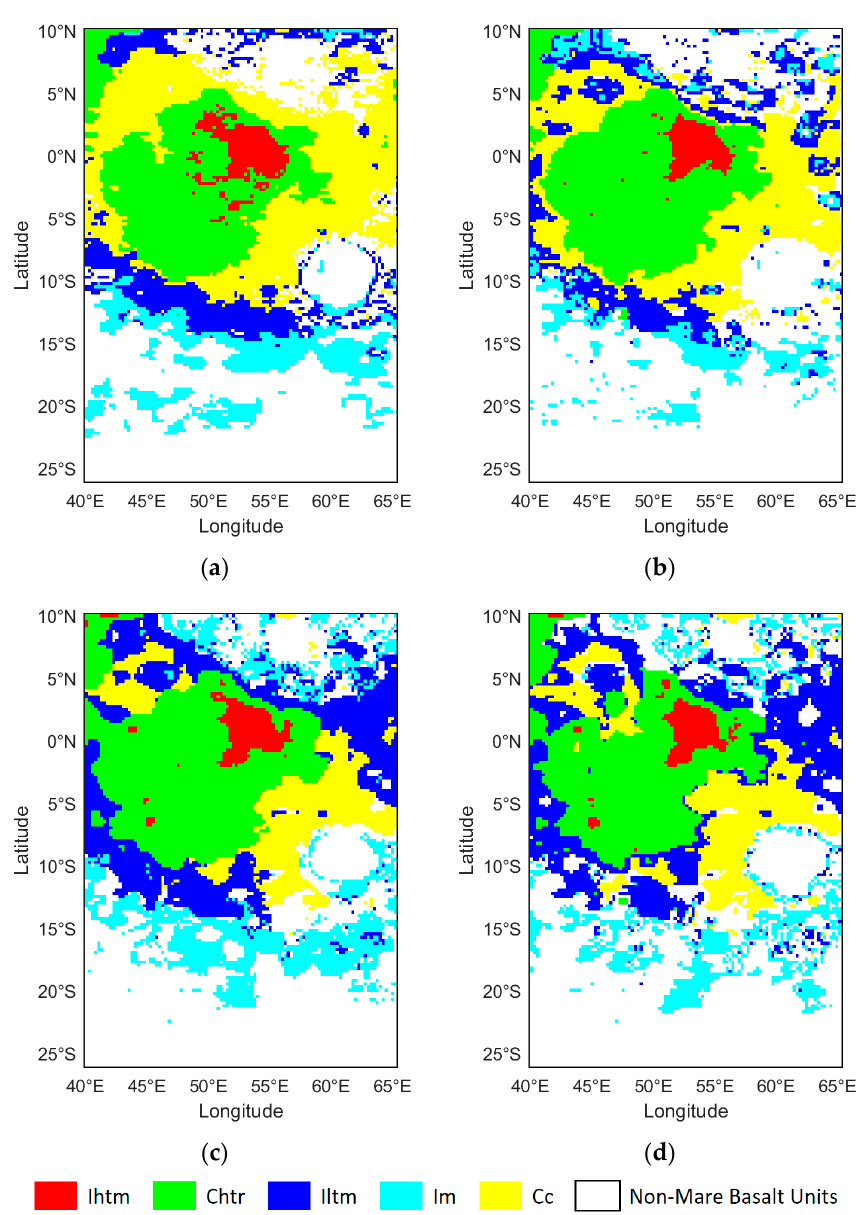
Figure 17. Classification results with features of different frequencies. ( a ) 3.0 GHz features; Figure 17. Classi fi cation results with features of di ff erent frequencies. ( a ) 3.0 GHz features; ( b ) 7.8 GHz features; ( c ) 19.35 GHz features; ( d ) 37.0 GHz features. ( b ) 7.8 GHz features; ( c ) 19.35 GHz features; ( d ) 37.0 GHz